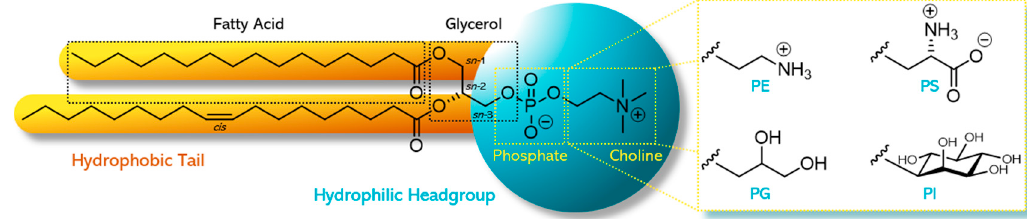
Figure 1. Chemical structure of a phospholipid as exampled by 1-palmitoyl-2-oleoyl- sn -glycero-3-phosphocholine (POPC) and the different alternative headgroups varying in the type of alcohol: phosphatidylethanolamine (PE) with ethanolamine, phosphatidylglycerol (PG) with glycerol, phosphatidylserine (PS) with serine, and phosphatidylinositol (PI) with